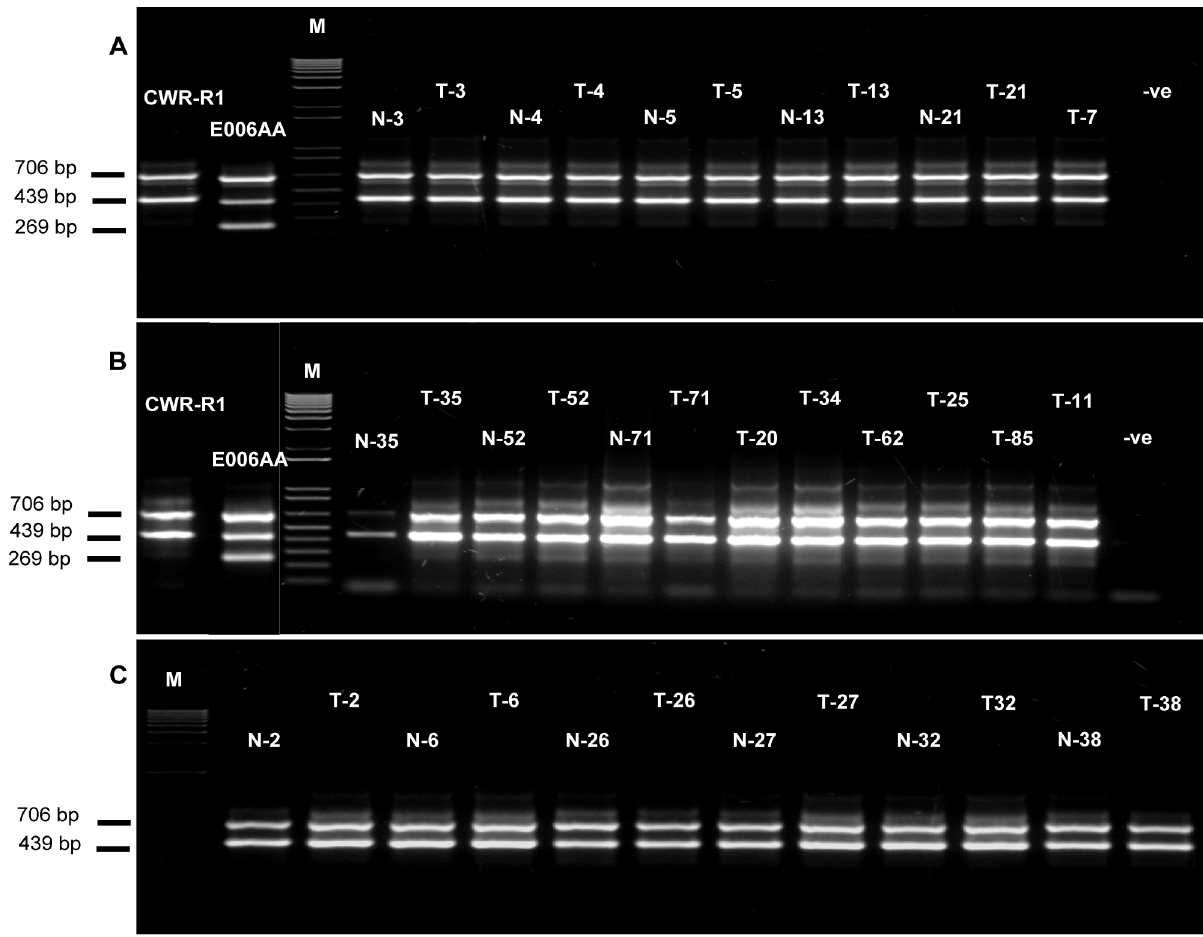
Figure 3. Allele-specific PCR genotyping of novel missense mutation identified in exon-8 of GRM1 gene in prostate tumors. Presence of C-allele showed amplification of a 439 bp fragment and presence of T-allele showed amplification of a 267 bp fragment. A nonspecific fragment of 706 bp was amplified in all samples.